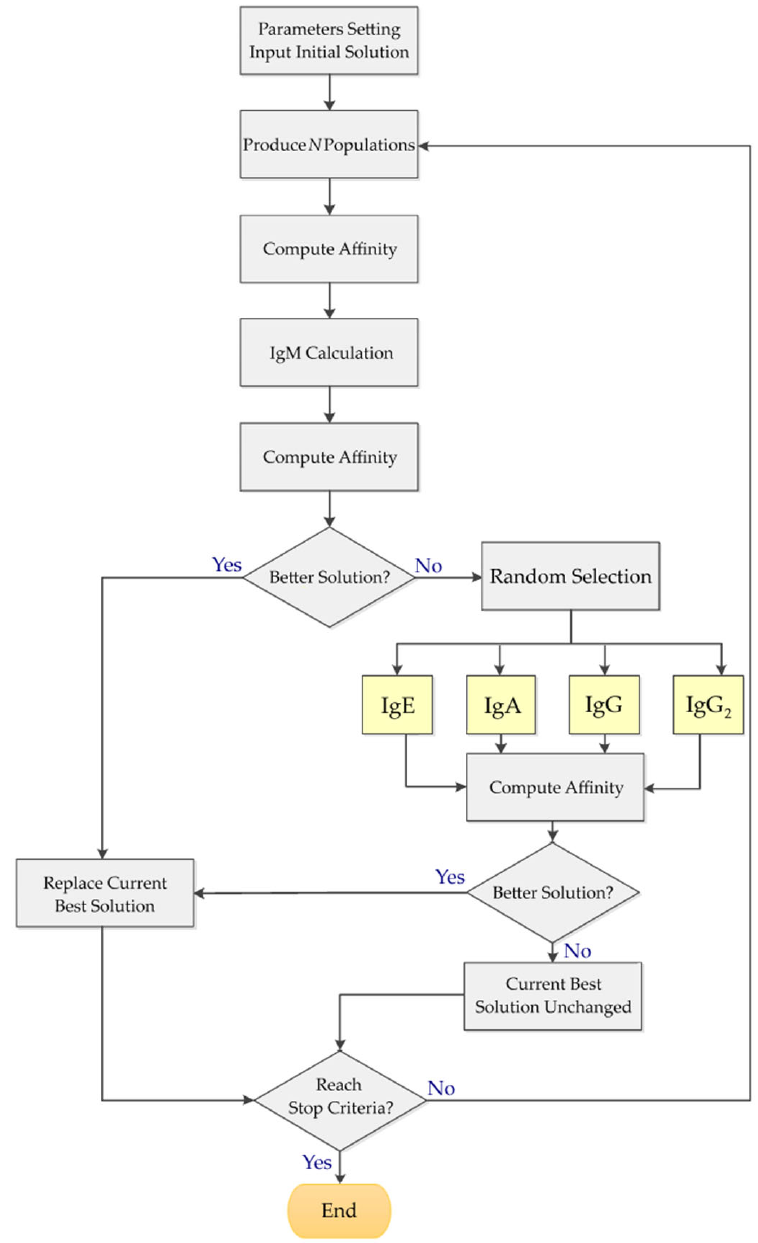
Figure 9. The processes of the proposed sAIS flowchart.